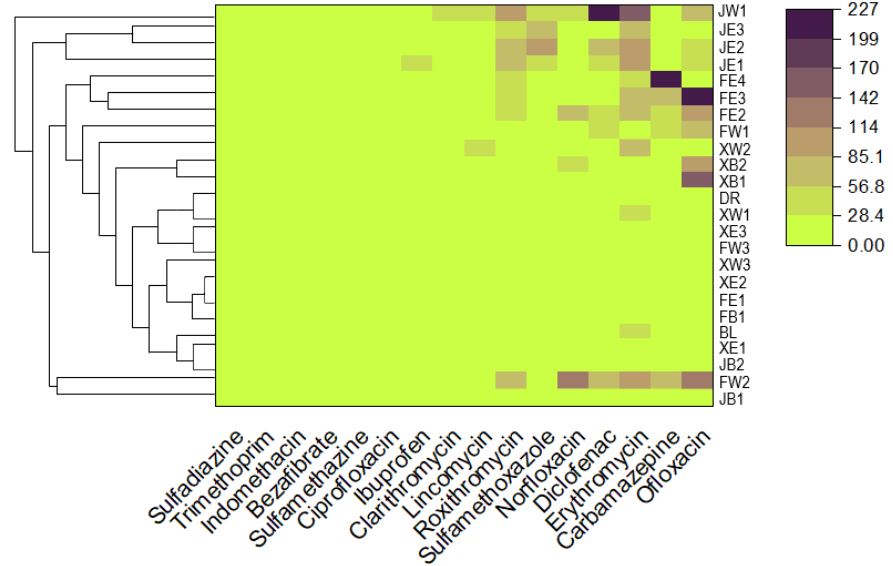
Figure 4. Heatmap of PPCP concentrations (scale in ng L − 1 ) in the Daqing River Basin, and cluster analysis of sampling sites.